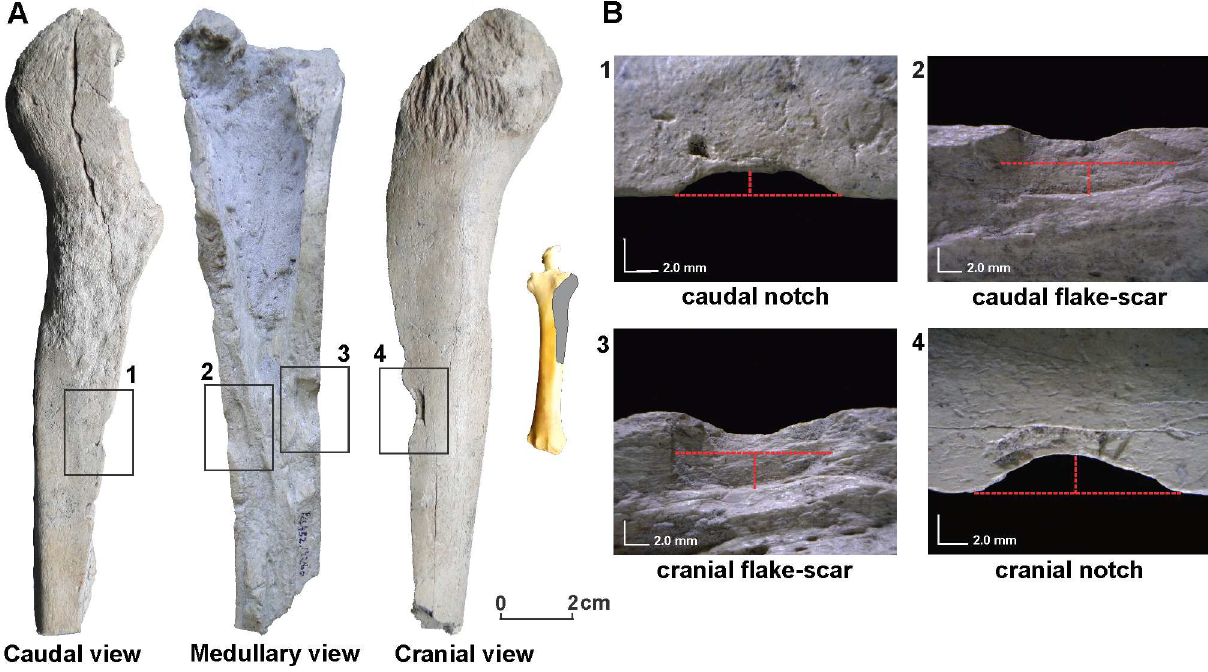
Fig 8. Radius of Equusneogeus dated12,170 ± 45 14 C yrs B.P. (UCIAMS-142842). (A) Threeviews with locationof impact.(B) A detailedview of notches and flake-scars; dottedlines illustratethe maximumdepthand breadthof notches and flake-scars.